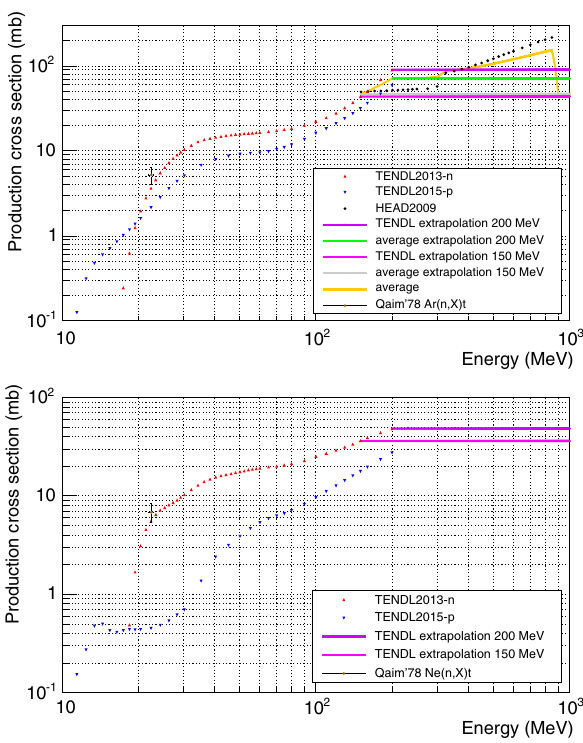
Fig. 8 Comparison of excitation functions for the production of 3 H by nucleons for Ar (top) and Ne (bottom) taken from different sources: TENDL-2013 and HEAD-2009 libraries together with several extrap- olations considered at high energies; the extrapolation of the average between the highest energy cross-section from TENDL and the cor- responding results from HEAD-2009 is labeled as “average extrapo- lation” and the average at each energy between TENDL data (and its extrapolation) and HEAD-2009 cross sections as “average”